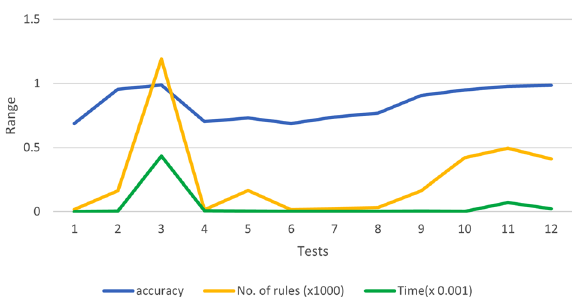
Figure 8. The relation between the generated rules and the processing